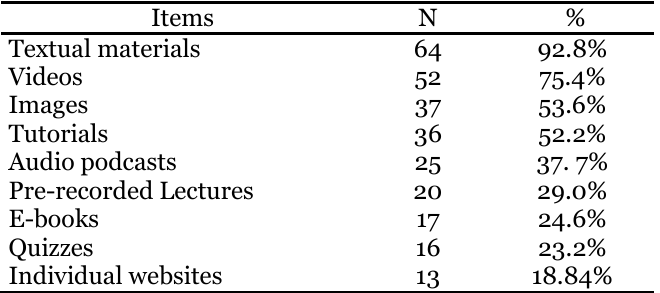
Learning Resources